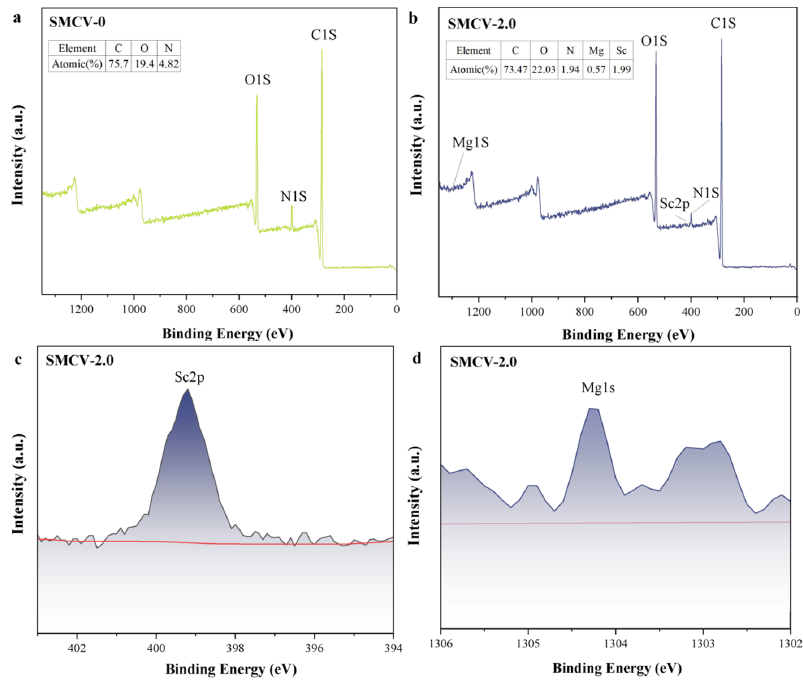
Figure 5. ( a ) XPS spectra of SMCV-0; ( b ) XPS spectra of SMCV-2.0; ( c ) Sc 2p XPS data of SMCV-2.0; ( d ) Mg 1s XPS data.